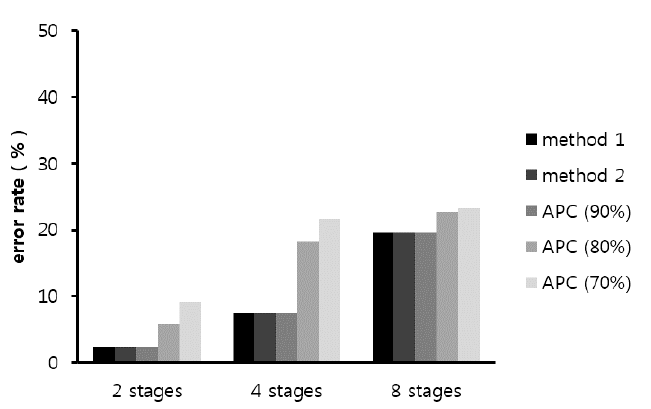
Figure 9. Operational stage vs. error